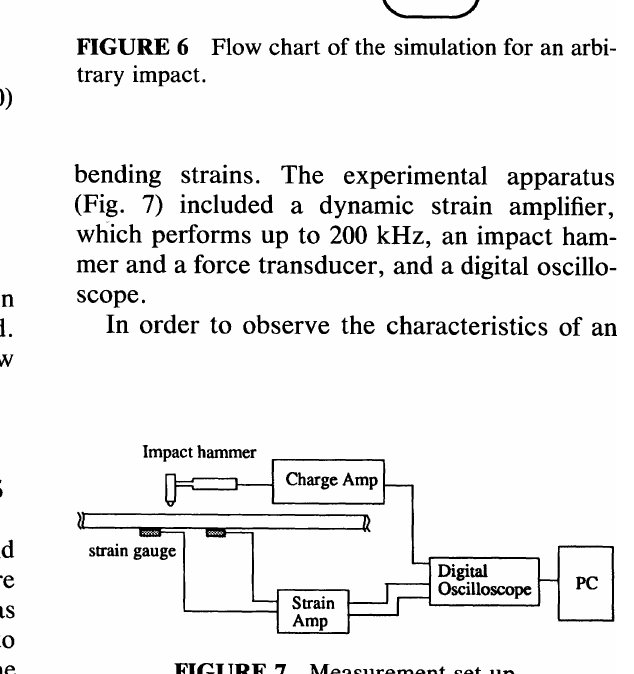
FIGURE 7 Measurement